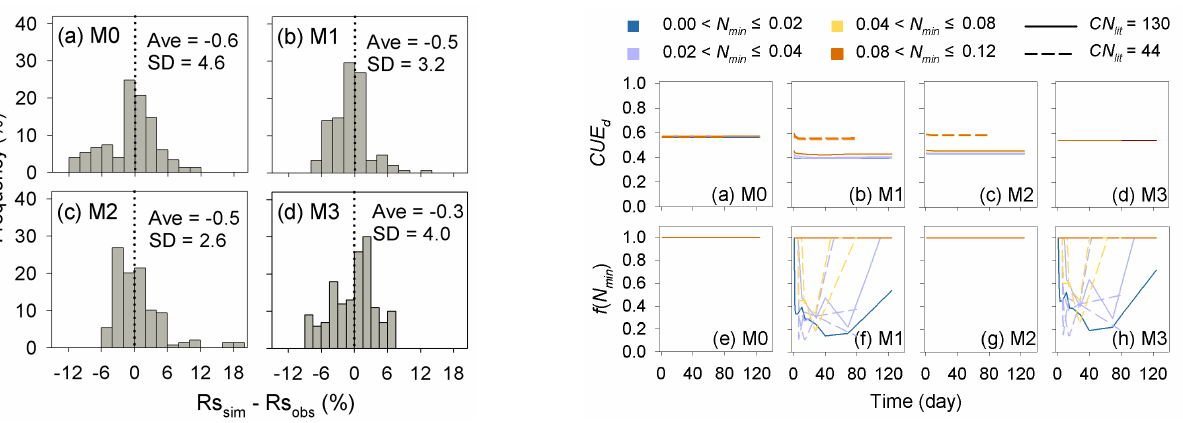
Figure A1. Distribution of the difference between the predicted cumulative respired litter C (Rs sim , %) and the observed values (Rs obs , %) for all experiments and points in time. SD is the stan- dard deviation of the biases. M0–M3 denote the four models tested in this study (Table 1).